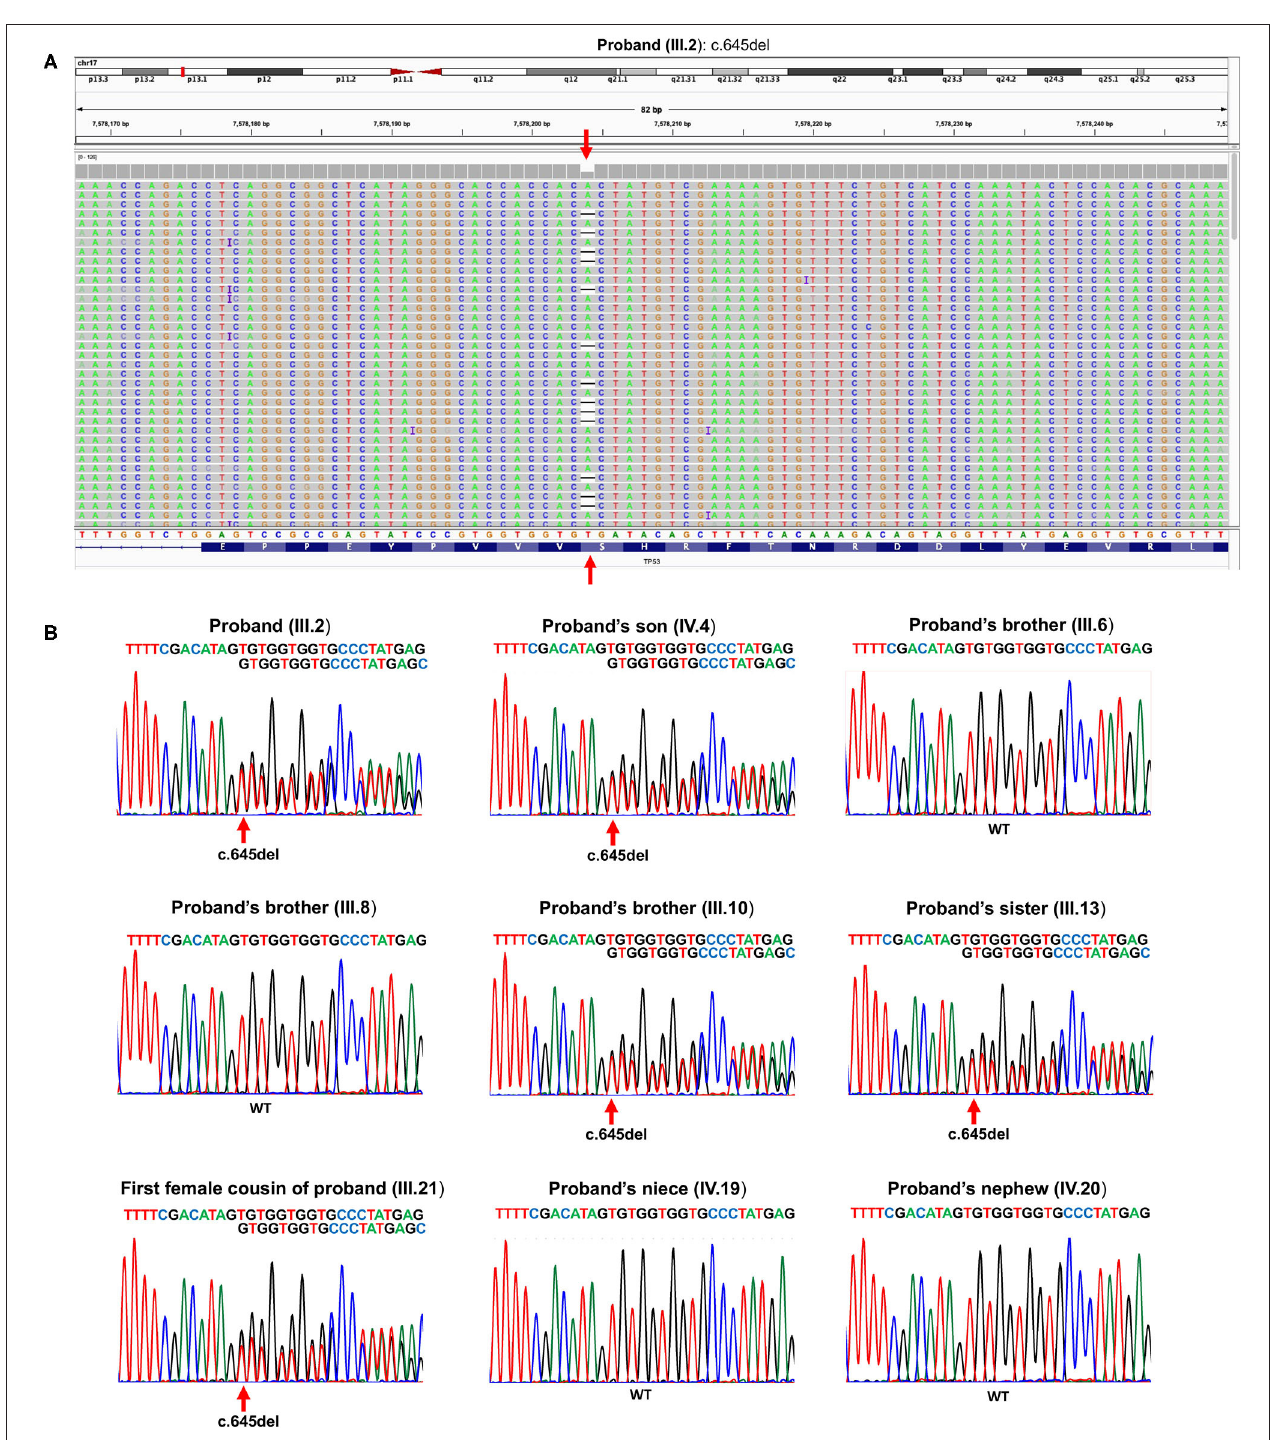
FIGURE 2 | (A) Snapshot of Integrative Genomics Viewer, showing the TP53 germline variant c.645del (p.Ser215Argfs*32) in the proband (III.2). (B) Sanger sequencing showing the c.645del pathogenic heterozygous TP53 variant in the proband (III.2), his son (IV.4), his brother (III.10), his sister (III.13), and his first female cousin (III.21). WT TP53 allele is shown in proband’s brother (III.6), proband’s brother (III.8), proband’s niece (IV.19), and proband’s nephew (IV.20). The red arrow indicates the heterozygous deletion.